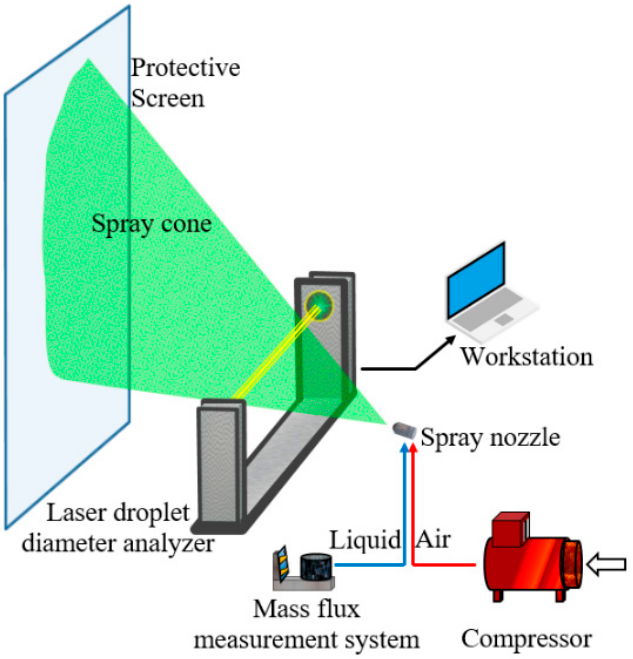
Figure 5. Test stand layout for spray particle dimensions measurement.